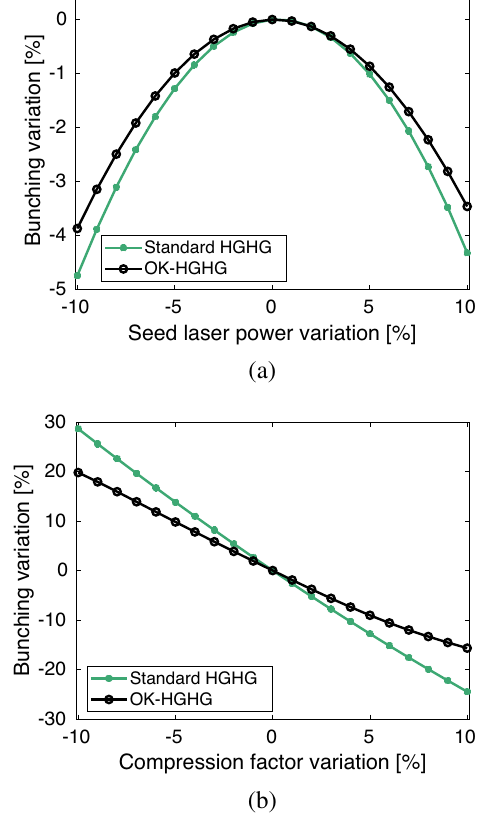
FIG. 5. (a) Bunching amplitude response to seed laser power fluctuations for a standard HGHG and an OK-HGHG setup. The nominal seed laser power is 27.7 MW and 54.5 kW for the standard and the OK-HGHG, respectively. (b) Bunching ampli- tude response to electron beam compression factor fluctuations for a standard HGHG and an OK-HGHG setup. The nominal energy spread and peak current are shown in Table I. They change proportionally when we vary the compression factor.